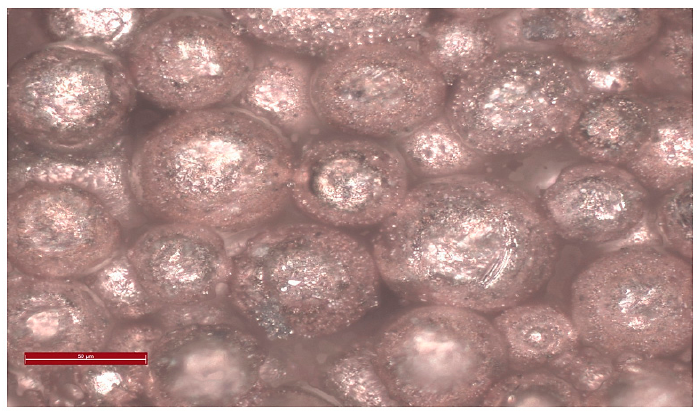
Figure 8. Microstructure of porous Cu samples obtained by hydrothermal sintering.